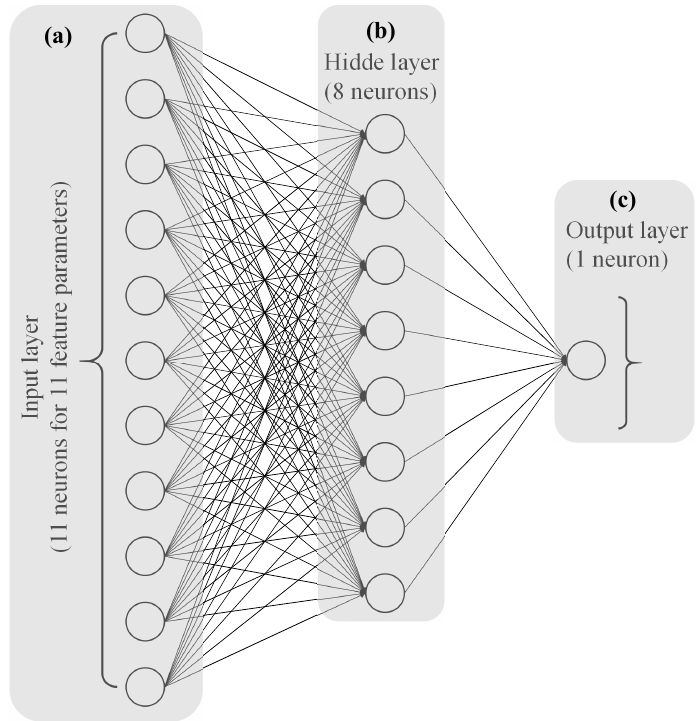
Figure 3. Structure of Back Propagation Neural Network (BPNN) for traffic-condition prediction. ( a ) Input layer of the BPNN, ( b ) hidden layer of the BPNN, and ( c ) output layer of the